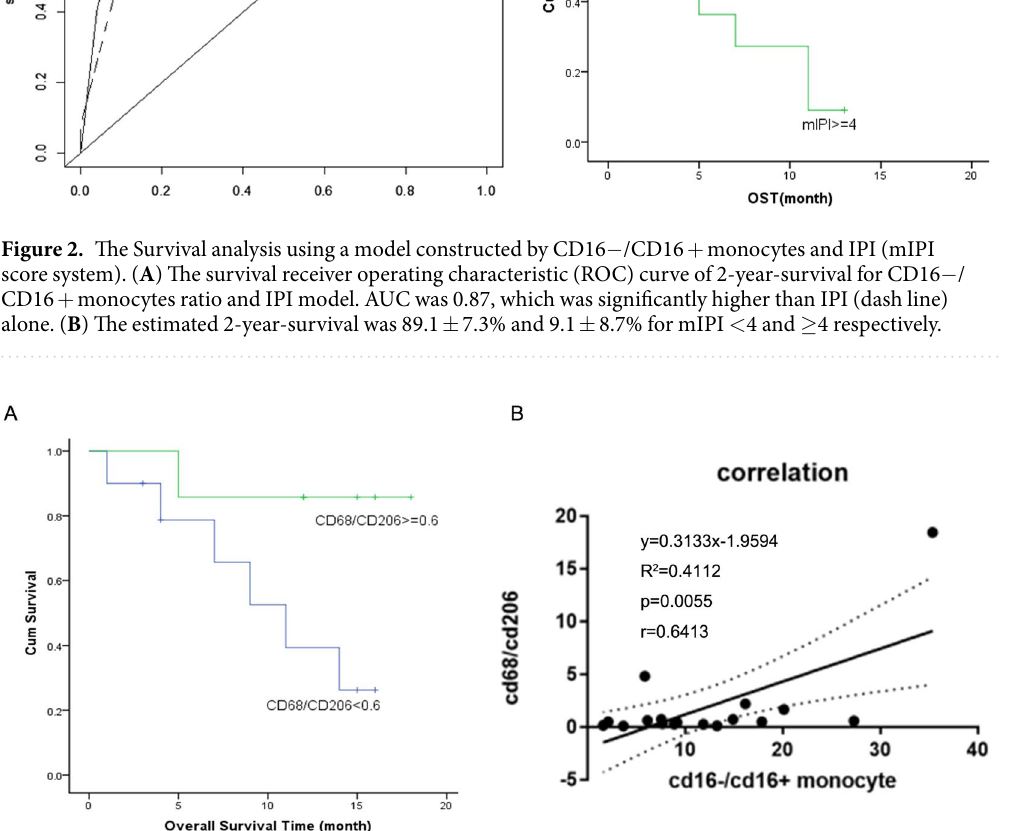
CD16 + subsets (Fig. 4) for transcriptome sequencing. Log2 fold change over 2 with Q value below 0.001 counted by DEGseq were defined as significantly differentially expressed genes. 1481 and 1937 differentially expressed genes were identified in CD16 − and CD16 + monocytes respectively between the patients and the health. KEGG pathway analysis revealed that signaling molecules involved in cancer development and immune system were major categories. Heatmap was performed and genes involved in signal transduction were displayed (Fig. 5). In brief, both CD16 − and CD16 + monocytes of T-NHL patients had increased expression of C1QC , C1QB , CD274(PDL1) , GBP5 and TNFRSF12A . HLA-B , HLA-C , HLA-DQA1 were highly expressed in CD16 − mono- cytes in patients while SDC3 , KCNMA1 , IL31RA , PDCD1LG2 ( PDL2 ), CXCL9 , ID1 , AREG , CD72 , PIM1 , espe- cially CCL4 were highly expressed in CD16 + monocytes compared to the control. Genes differentially expressed between CD16 − and CD16 + monocytes were also compared between the patients and the controls. B3GNT7 , TIAM2 , NT5DC4 , XPNPEP2 , TMPRSS3 , ACY3 were upregulated only in T-NHL patients in CD16 + monocytes.